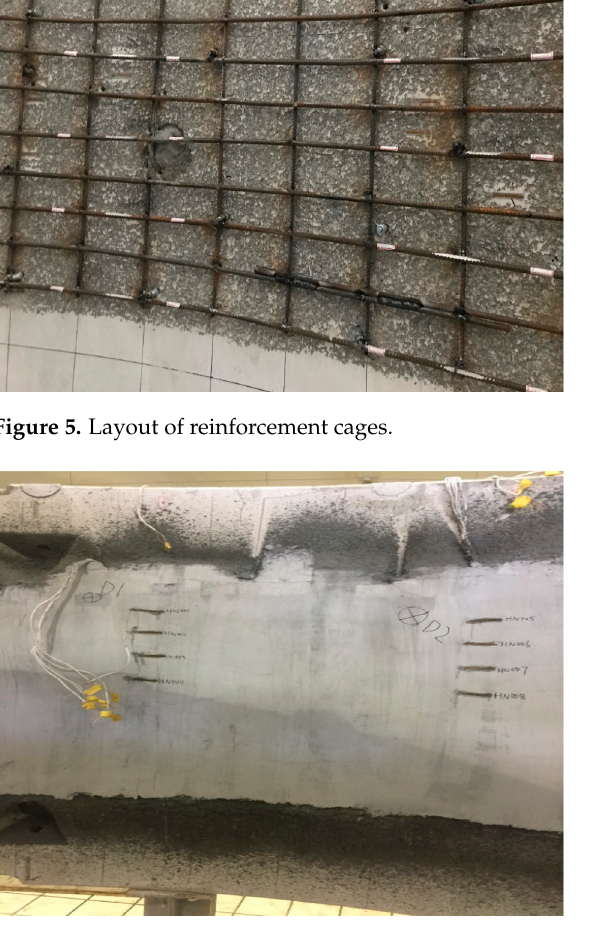
Figure 6. Structure strengthened by in situ spraying.